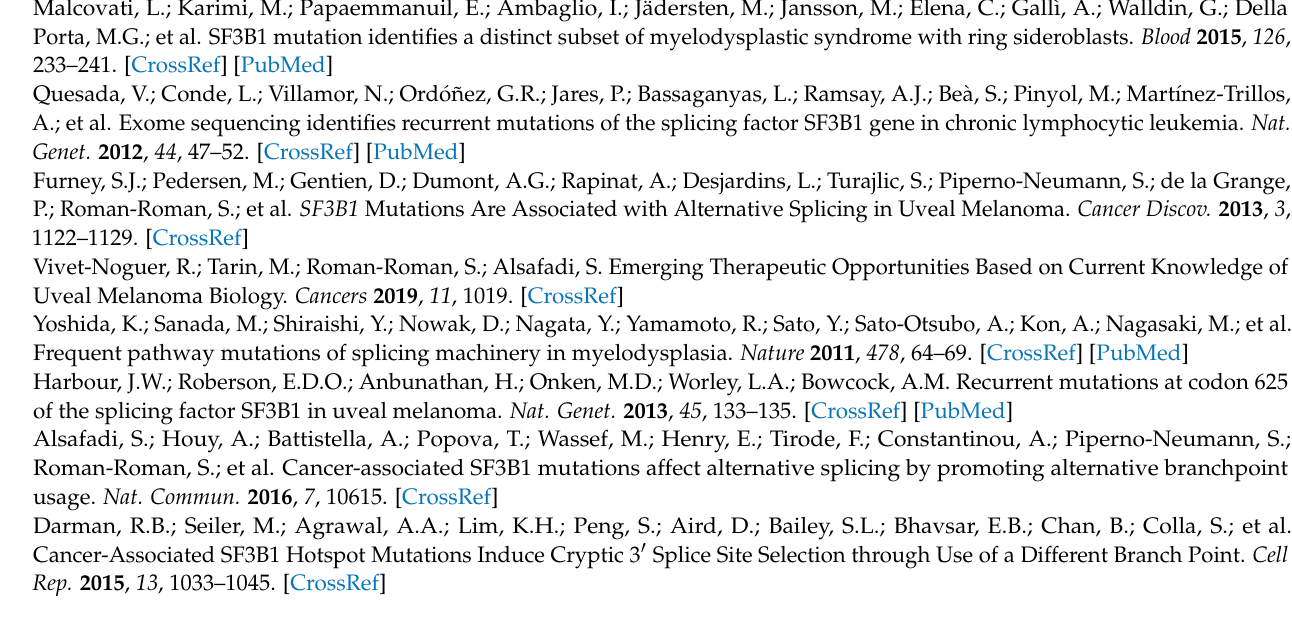
to SF3B1 WT cells; Figure S4: Quantifications of replicates of western blots of metabolic proteins; Figure S5: SF3B1 WT and SF3B1 R625G cells display comparable ROS levels and equivalent mito- chondrial content; Figure S6: SF3B1 G742D and SF3B1 K666T cells display a decreased mitochondrial respiration; Figure S7: SF3B1 G742D and SF3B1 K666T cells display high sensitivity to glycolysis inhibi- tion; Table S1: Differentially-expressed splice junctions in SF3B1 R625G versus SF3B1 WT Mel202 cells; Table S2: Misspliced transcripts in the SF3B1 R625G Mel202 cells detected in the input, monosomal and polysomal fractions as determined by RNA-seq; Table S3: Gene Ontology enrichment analysis of the translated misspliced transcripts in SF3B1 R625G Mel202 cells; Table S4: Differentially-abundant proteins in SF3B1 R625G versus SF3B1 WT Mel202 cells as determined by LC-MS/MS; Table S5: Gene Ontology enrichment analysis of the differentially-abundant proteins in SF3B1 R625G versus SF3B1 WT Mel202